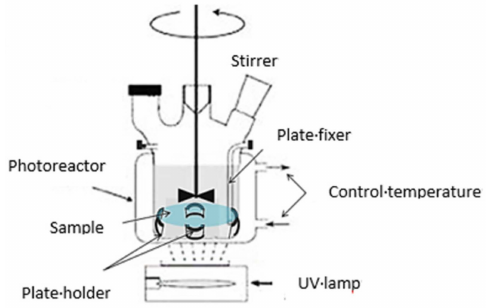
Figure 1. Sketch of the set-up used for the photocatalytic